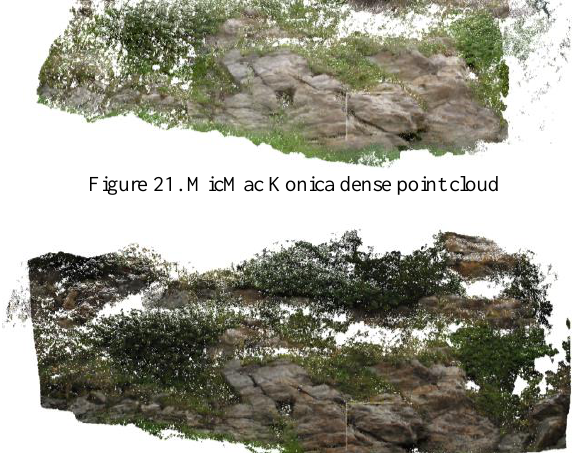
Figure 17. SURE Konica dense point cloud